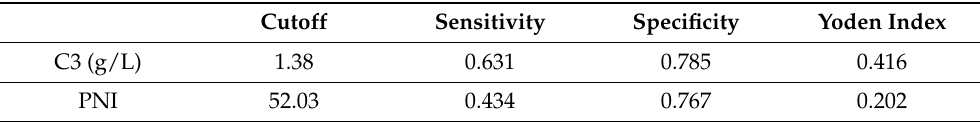
Figure 4. Receiver operating characteristic (ROC) curve of the C3 and the PNI and the ROC curve of the two variables. Table 5. The cutoff of the C3 and the